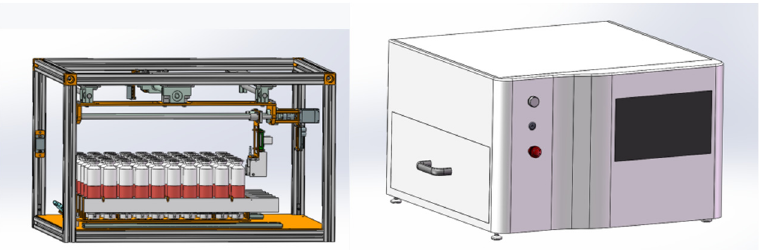
Figure 2. Three dimensional (3D) model of the mechanical structure of spectroscopic high throughput blood culture apparatus.